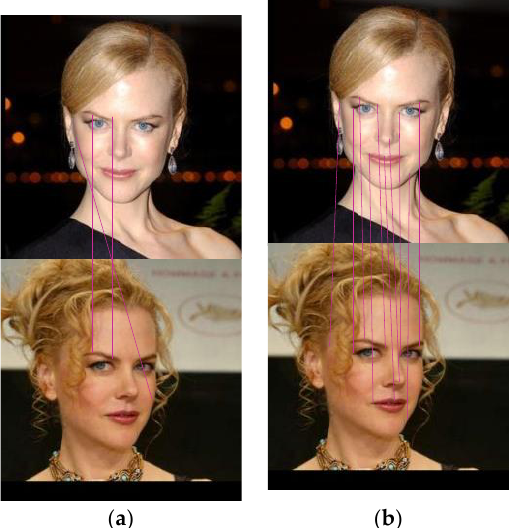
Figure 13. Comparison of matching effect using the LFW face database: ( a ) SIFT Model; ( b ) SIFT/RITF Model.